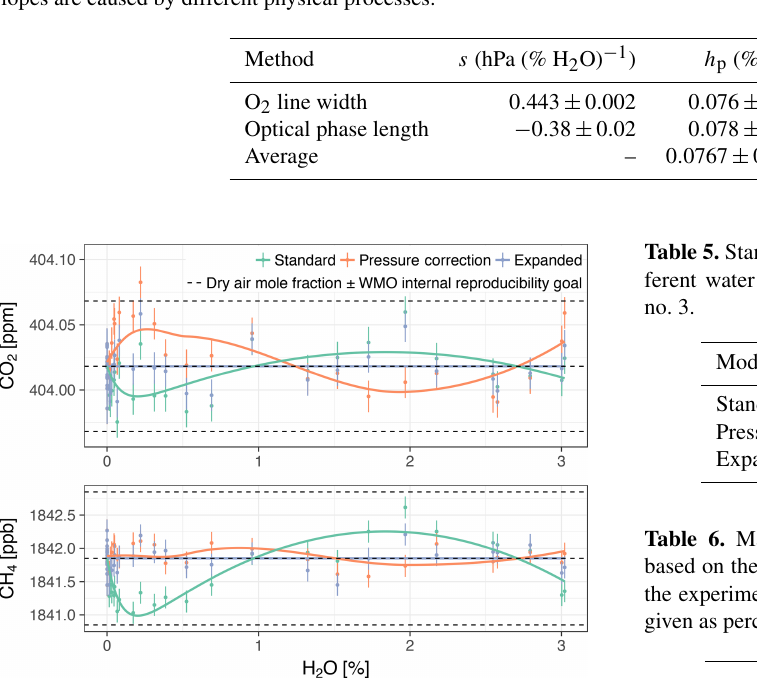
Table 4. Coefficients for the empirical cavity pressure model Eq. (4) based on spectroscopic methods (estimates and standard errors). The last line shows averages and, as uncertainty, half the spreads of the individual estimates. The average of the slopes is not given because the slopes are caused by different physical processes.